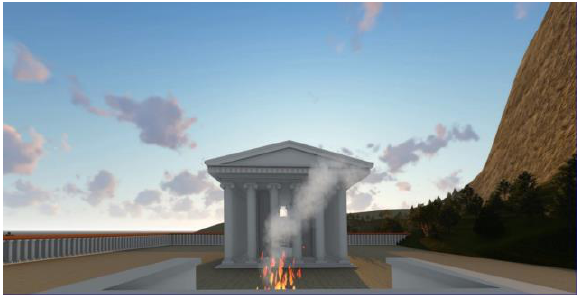
Figure 9. Reconstruction of the Temple Athena Polias at Priene.